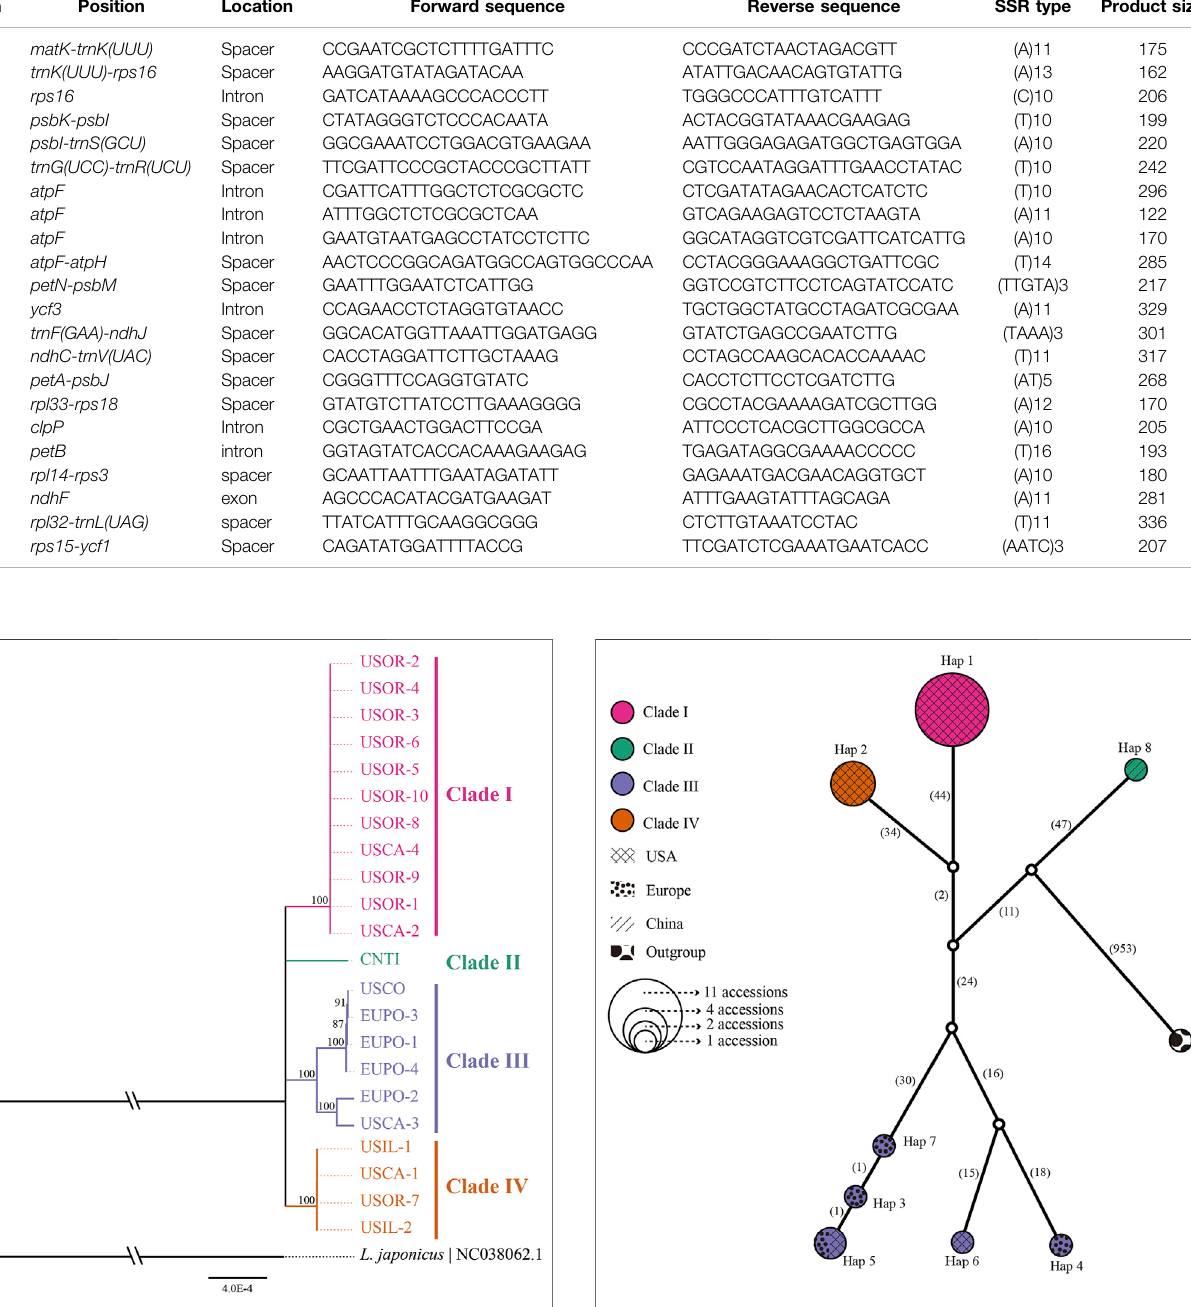
FIGURE 8 | Network for all 22 L. cardiaca accessions base on chloroplast genome sequences. The relative size of each circle corresponds to proportional to haplotype frequencies. Different color represented different clades consistent with phylogenetic relationship. Different texture represented different